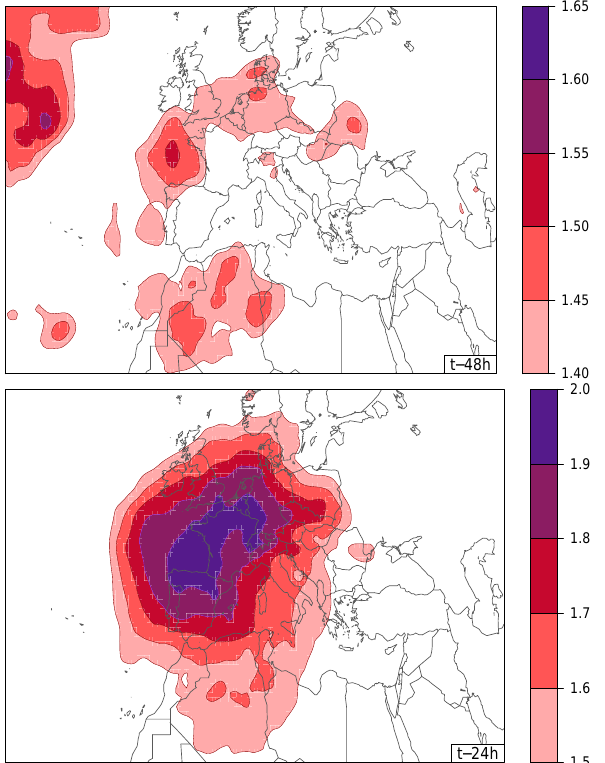
Fig. 7. Mean sensitivity fields obtained by GH09 for 25 cyclones types computed over all considered precursor conditions and levels (mb, shaded) for t − 48h (upper panel) and t − 24h (lower panel). Note the scale change between figures. (Updapted from